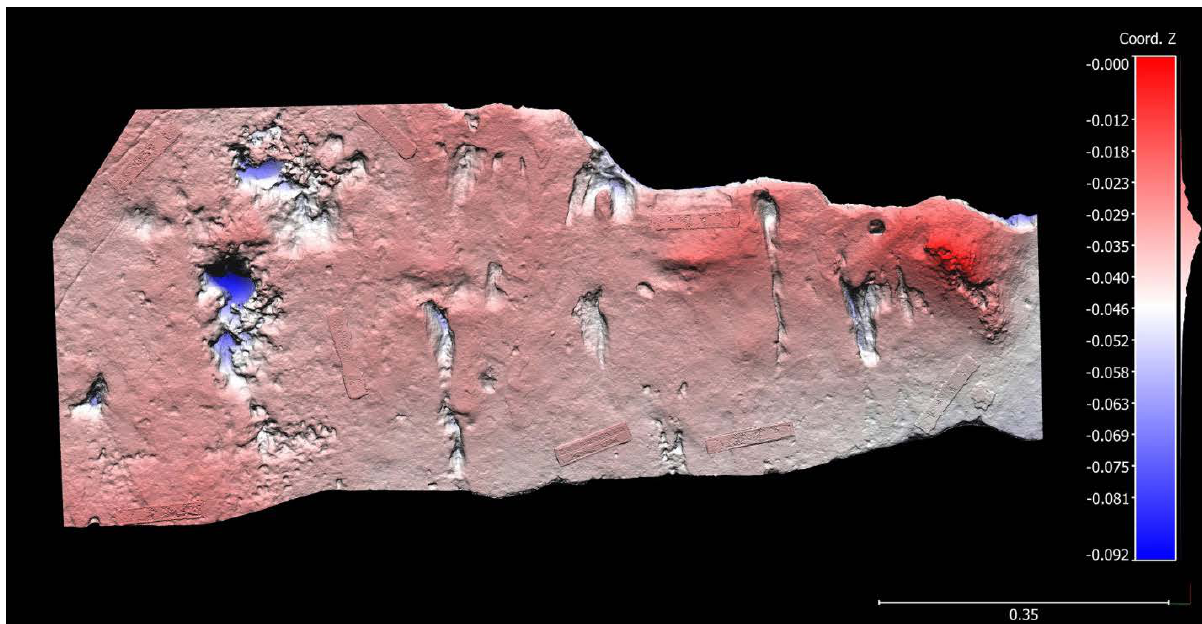
Figure 3: Photogrammetry colour mesh of tracks and swim traces, facing south. The three-dimensional model was generated with Agisoft MetaShape Professional (v. 1.0.4) using 108 images. Photos were taken an average 28.6 cm from the surface. The reprojection error is 0.381 pix. Vertical and horizontal scales are in